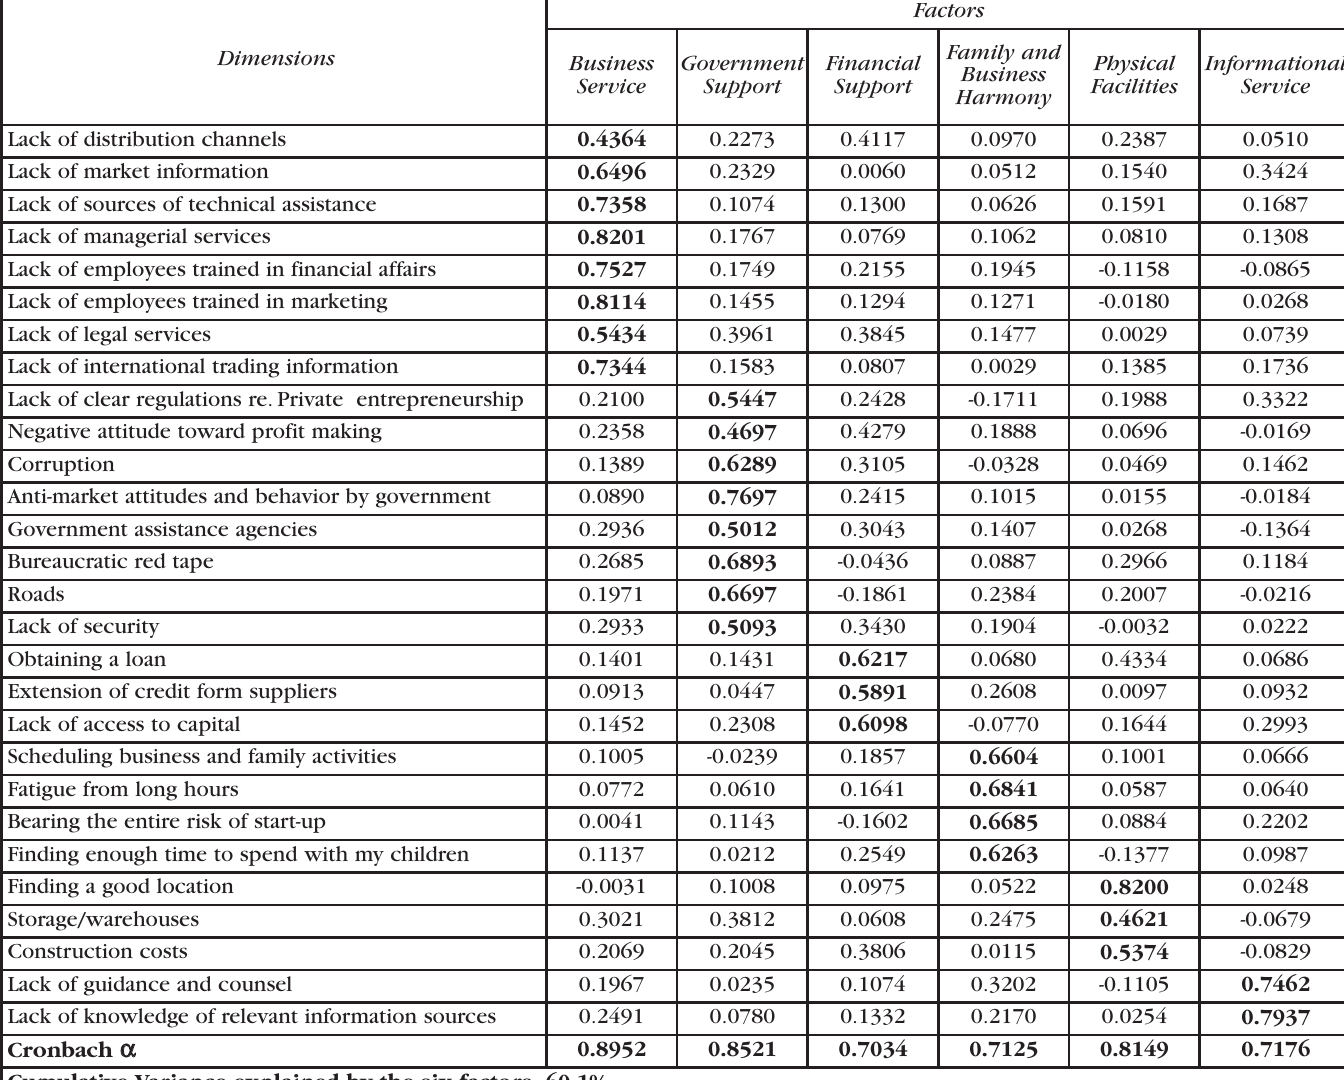
Table 3. Factor Analysis of Infrastructure